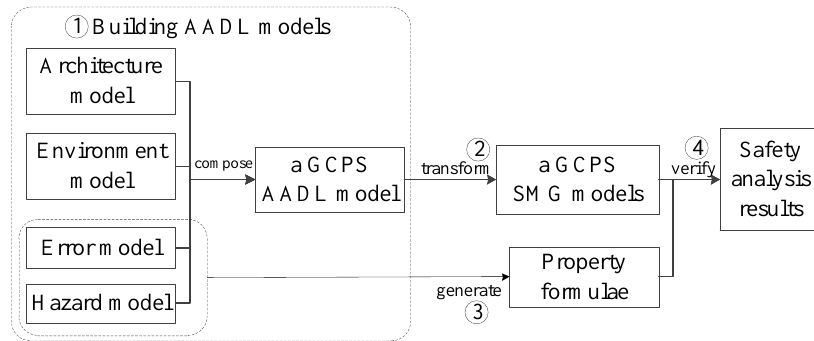
Figure 1. Proposed safety analysis framework for